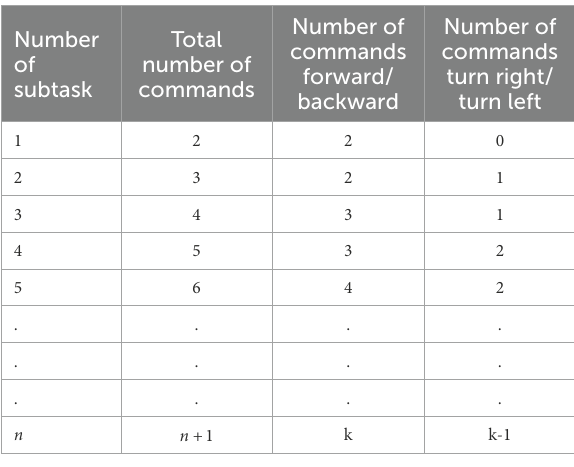
TABLE 2 Basic sequences of commands.